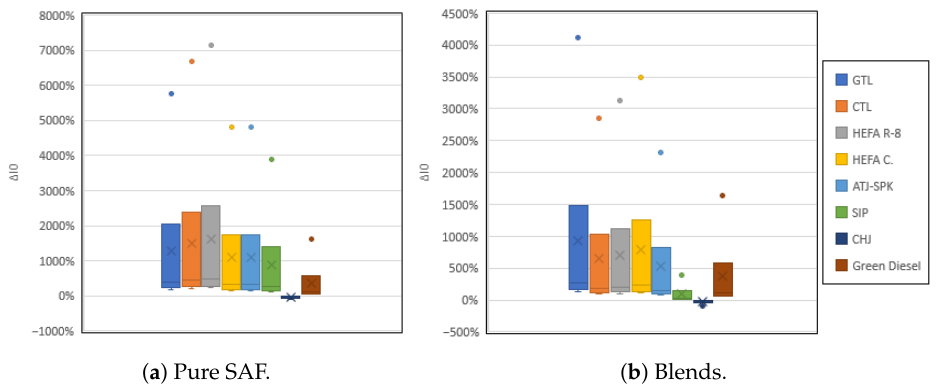
Figure 17. RDs in initial ice mass ratios for ambient relative humidities at formation in the range of 40% to 41%.